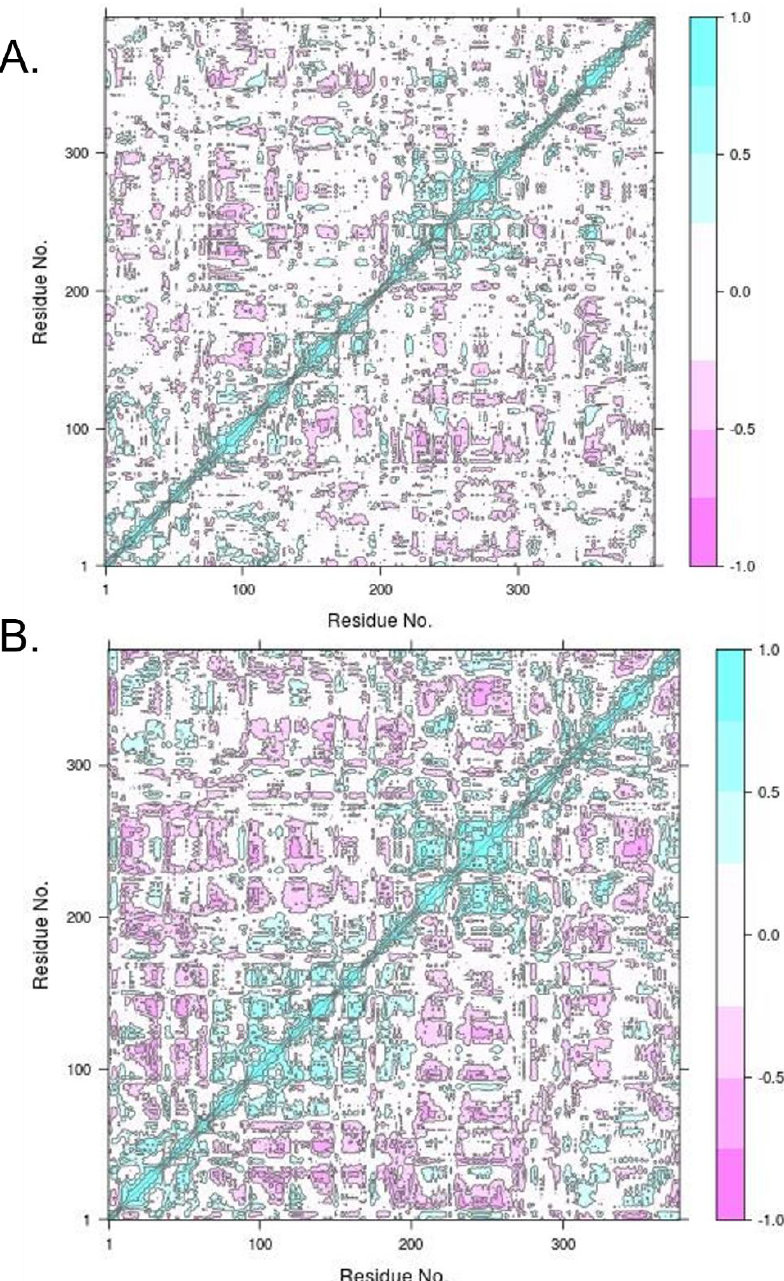
Figure 8. NmW-GT correlative motions. ( A ) NmW-GT model; ( B ) BshA structure. The DCCM matrix was constructed and plotted with Bio3D R library. Regions that move in a correlated manner are shown in green and anticorrelated ones are shown in pink. Reprinted with permission from From [63]. Copyright 2021 Subhadra Paudel.